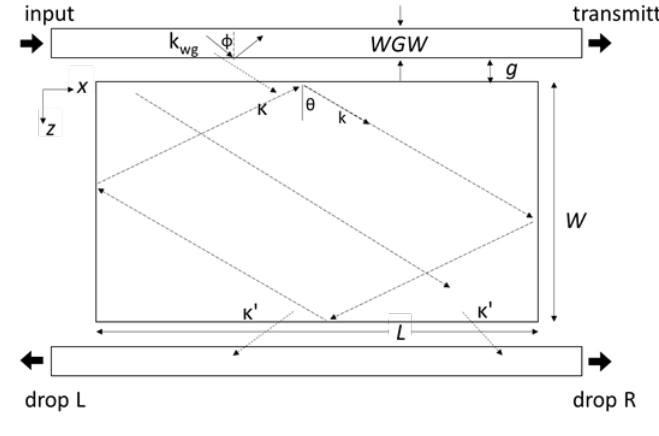
Figure 1. Schematic of the rectangular resonator.